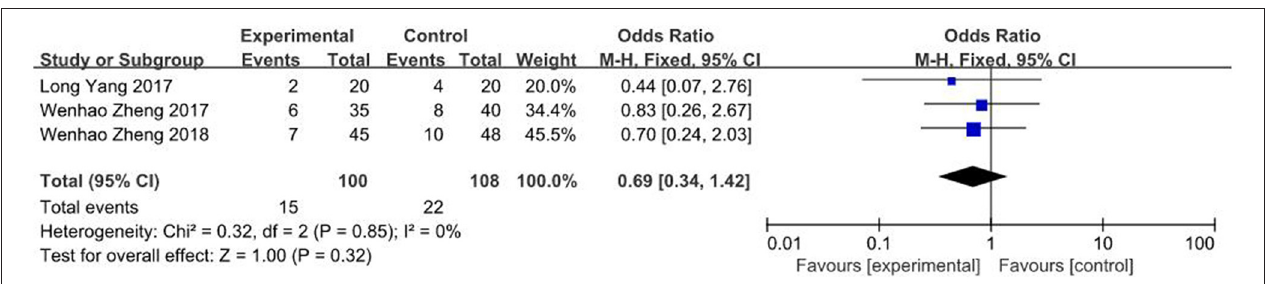
FIGURE 9 | Meta-analysis results of complication rate.